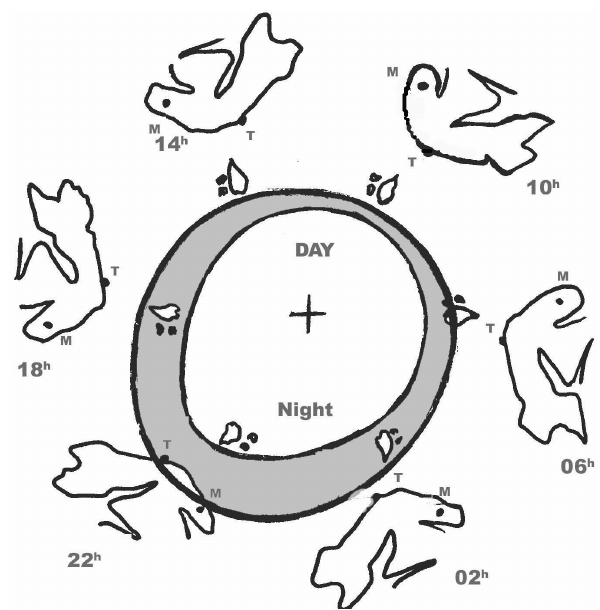
Figure 11. Position of Spitsbergen relative to the auroral oval during solar activity minimum.